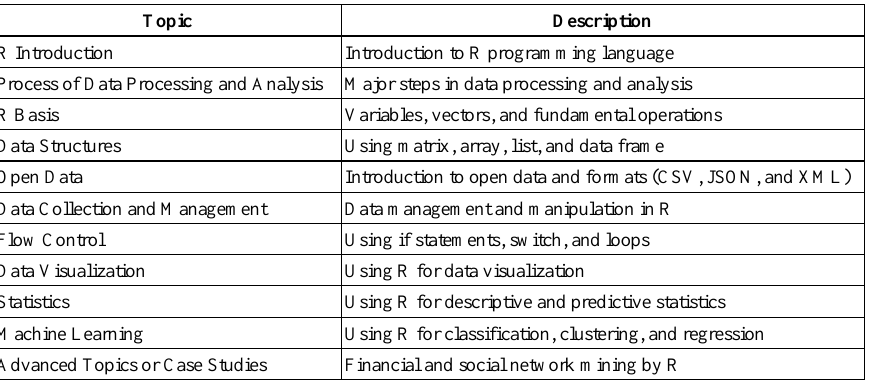
Table 4. Syllabus of statistical software for data